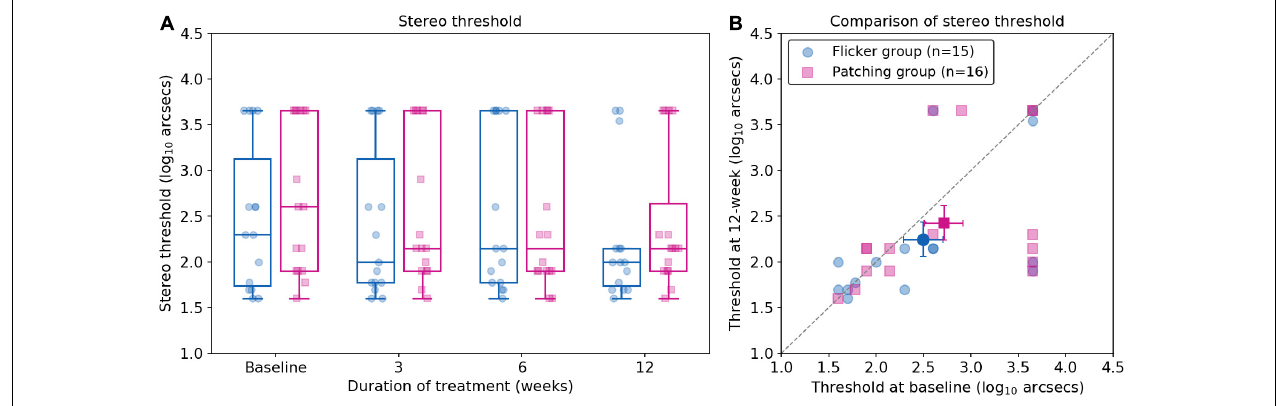
FIGURE 4 | Stereo thresholds (log arcsecs) as measured with the Titmus Stereo test. (A) Boxplots of stereo thresholds in Flicker and Patching treatment groups. (B) Individual data point of stereo thresholds measured at baseline and at 12 weeks of treatment. Both panels are plotted similarly to Figure 2